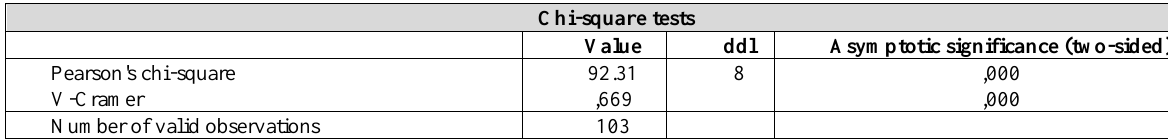
Table 3. Chi-square and V-Cramer Test Between the Type of Autism and the Repercussions on the Health of the